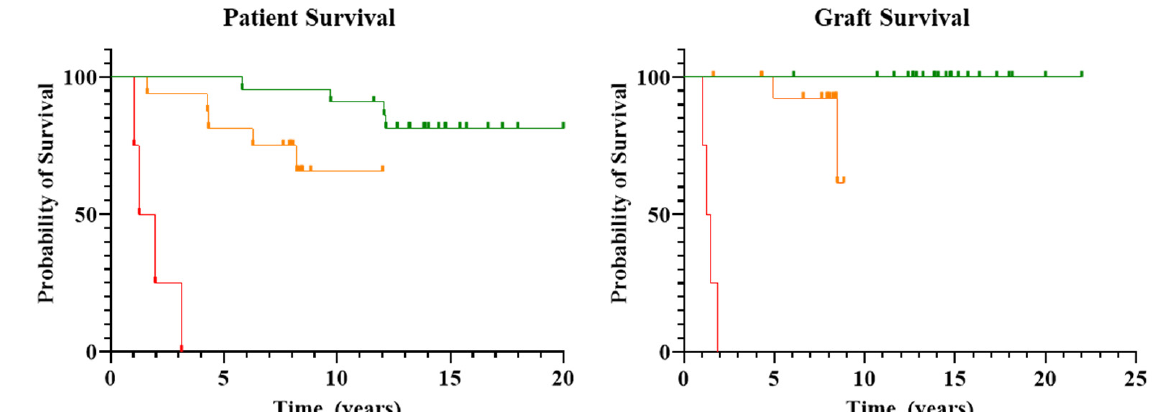
Figure 1. Patient and graft survival. Kaplan-Meier survival analysis was performed for both patient and graft survival of patients in Groups A, B and C. Group A is visually depicted in green, Group B in orange, and Group C in red. Clear differences in the probability of both patient and graft survival can be seen, with Group A having the highest probability of survival, while Group C has the lowest probability of patient and graft survival.